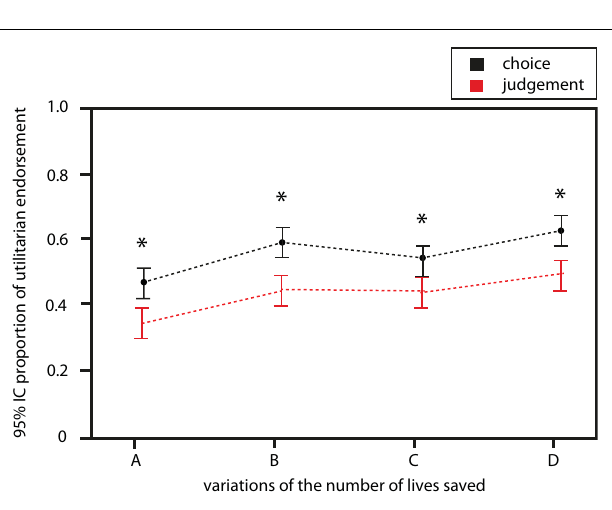
FIGURE 2 | Influence of the variation of number of live saved on the probability of utilitarian response in both conditions .